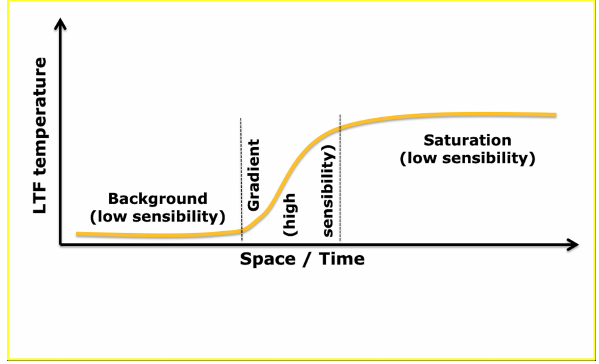
Figure 4. Space/time sensibility of a LTF to temperature